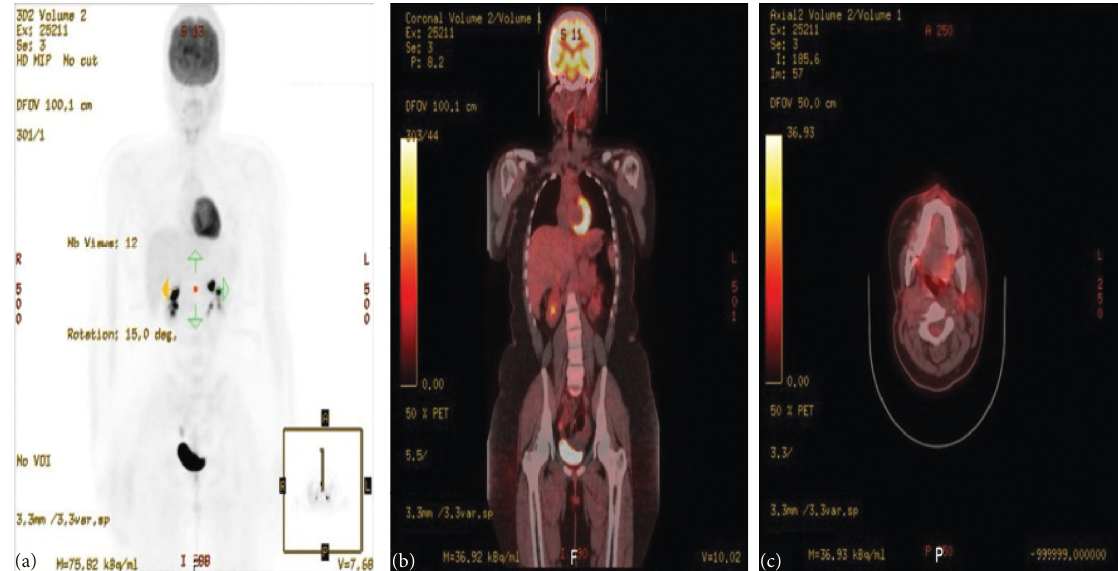
Figure 4: The PET scan in November 2018. The study was compared with the previous scan of November 20, 2017. Overall, the study ((a)–(c)) is stable without any evidence of local recurrence or distant